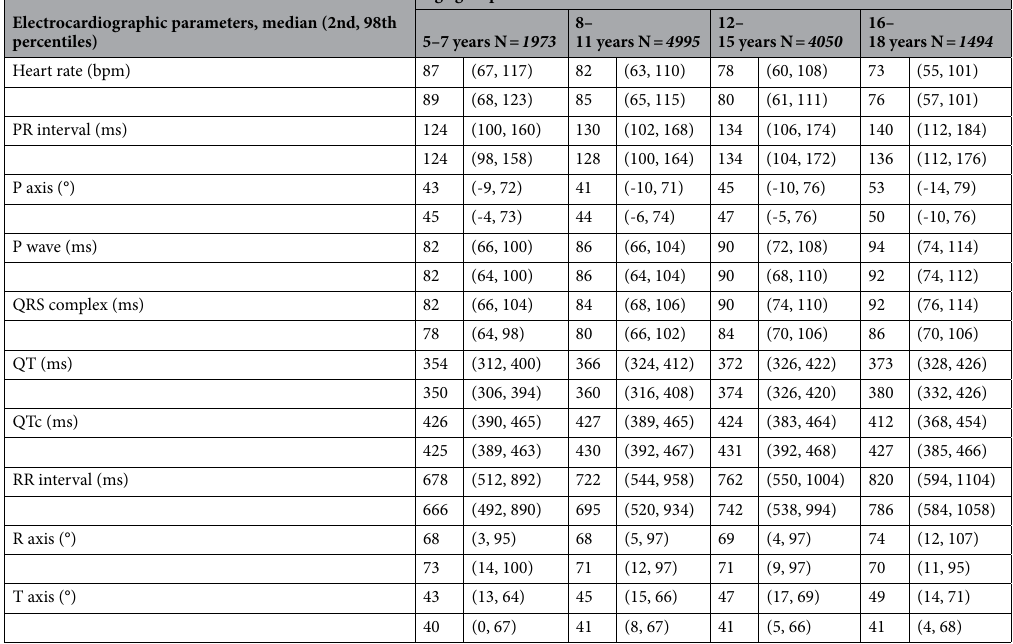
Table 2. Electrocardiographic parameters according to age and gender (males, upper row and females, lower